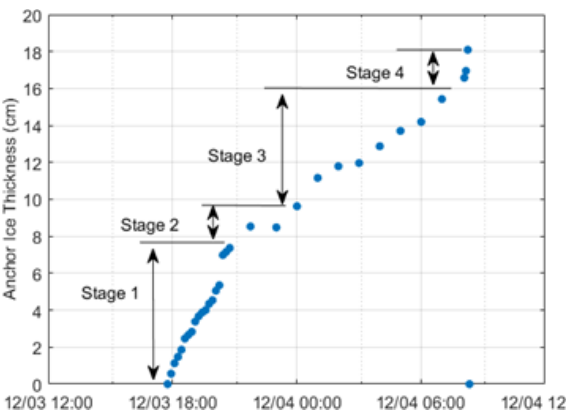
Figure 13. Time series of anchor ice thickness growth due to frazil deposition (stages 2 and 3) for all the measured events. For illus- trative purposes, linear growth rates of R = 0 . 3, 0.6, and 0.9cm/h were added to the plot.